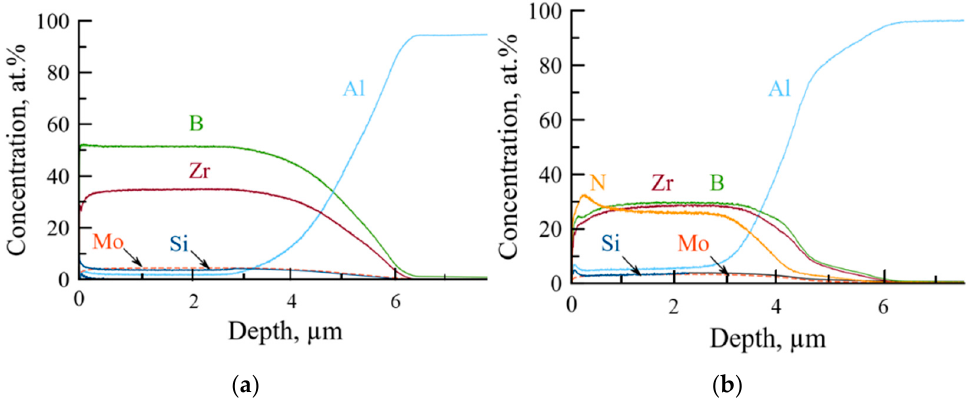
Figure 2. Elemental profiles of Coatings 1A ( a ) and 2N ( b ). Depth-averaged elemental concentrations are provided in Table 1. Table 1. Composition and mechanical properties of the coatings. Table 1. Composition and mechanical properties of the